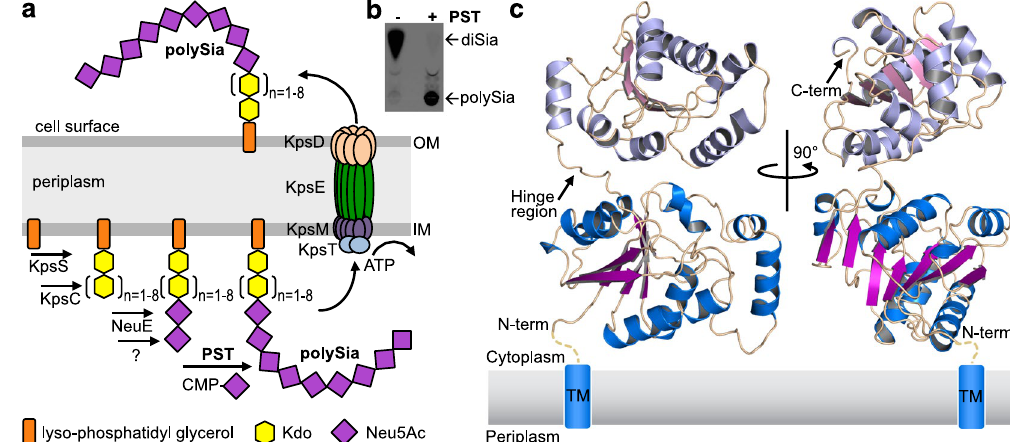
Figure 1. PST catalysed biosynthesis of polysialic acid and structure of Mh PST. ( a ) The biosynthesis of capsular polysialic acid (polySia) is initiated at the cytoplasmic side of the plasma membrane by the transfer of a Kdo linker onto the lipid carrier lyso-phosphatidyl glycerol catalysed by KpsS and KpsC. Extension to polySia requires sialic acid priming involving the action of NeuE, before PST can catalyse the assembly of homopolymeric, α -2,8-linked polySia. The completed, lipid-bound structure is translocated to the cell surface in an ATP-dependent manner by an export complex composed of KpsDEMT. ( b ) In vitro polysialylation activity of Mh PST using a soluble BDP-Sia 2 Lac acceptor substrate was analysed by TLC. Polysialylation results in suppressed migration of the acceptor (A complete scan of the TLC plate is shown in Supplementary Figure S7). ( c ) Ribbon diagrams of the Δ 20 Mh PST apo structure showing the GT-B fold. In the N-terminal Rossmann fold, helices are coloured in marine and β -sheets are coloured in purple, whereas in the C-terminal Rossmann fold, helices are coloured in light blue and β -sheets are coloured in pink. The presumed position of the N-terminal membrane anchor is